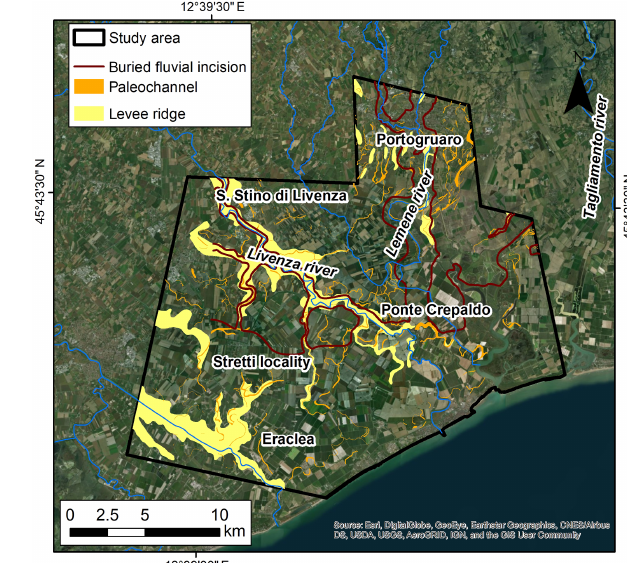
Figure 1. Geographical